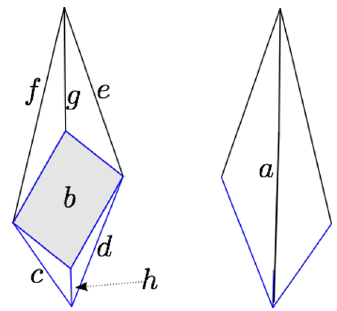
Figure 13 . The Newton polytope N 2 ; 2 with the initial forms (5.1): top (left) and bottom (right). Blue faces are those, which do not have other points rather than the